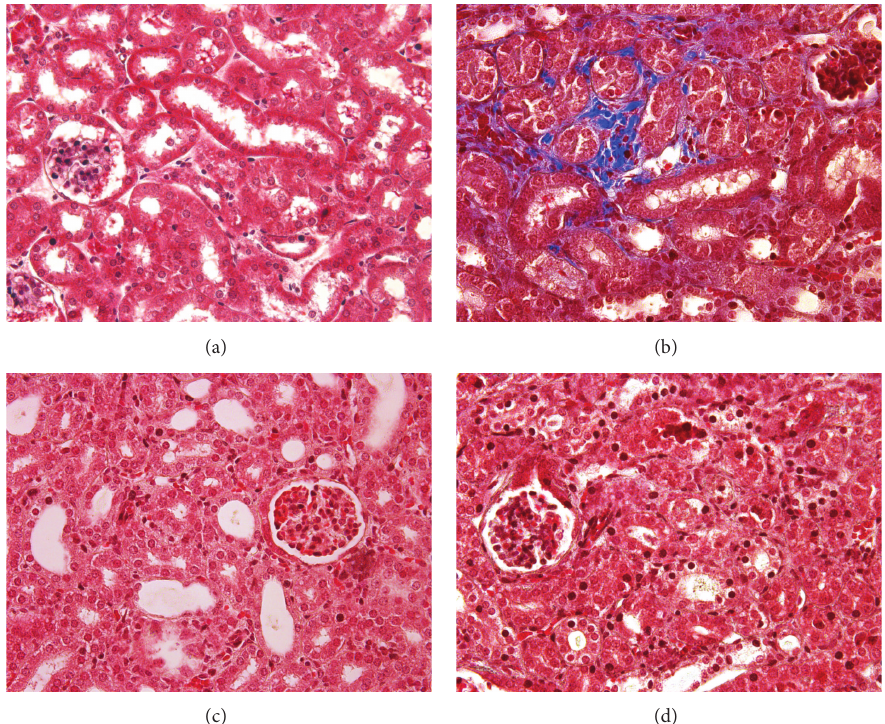
Figure 5: Renal fibrosis by Masson’s Trichrome staining at day 7 of (a) control, (b) UUO treatment, (c) UUO with Ac-SDKP treatment, and (d) UUO with Captopril treatment group. Magnification